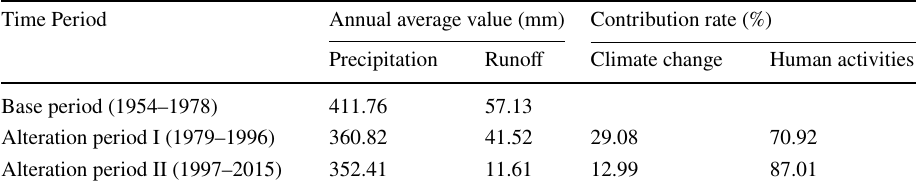
rate of runoff variation in Huangfuchuan River basin calculated by double-mass curve method